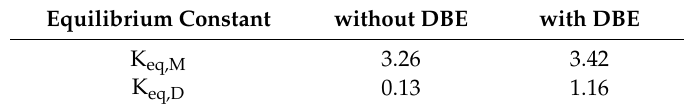
Table 2. Equilibrium constants in the absence and presence of DBE as solvent.